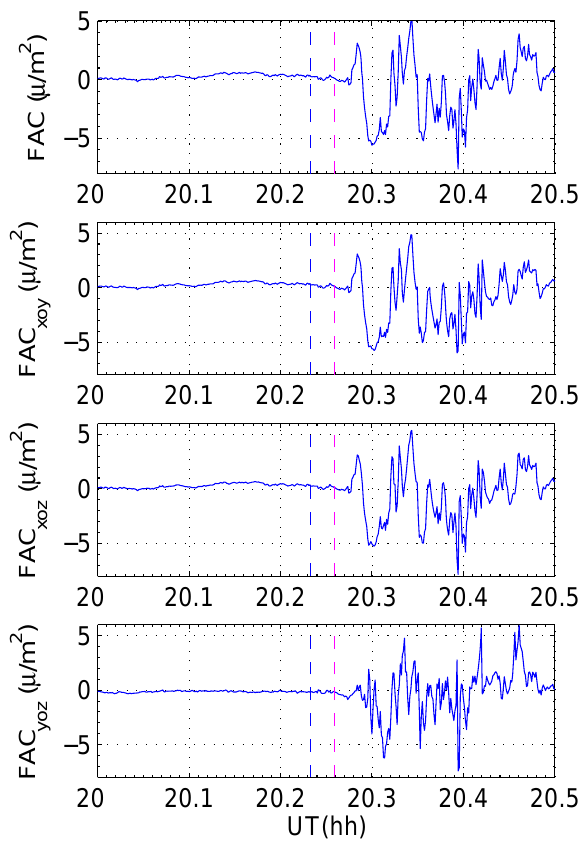
Fig. 8. Current density estimates derived from the Cluster quar- tet. From top to bottom are shown FACs density and current com- ponents in the GSE x-y, x-z and y-z planes. The vertical dashed blue line denotes the substorm onset time and the dashed red line, 1.44min later, the time of field dipolarization at